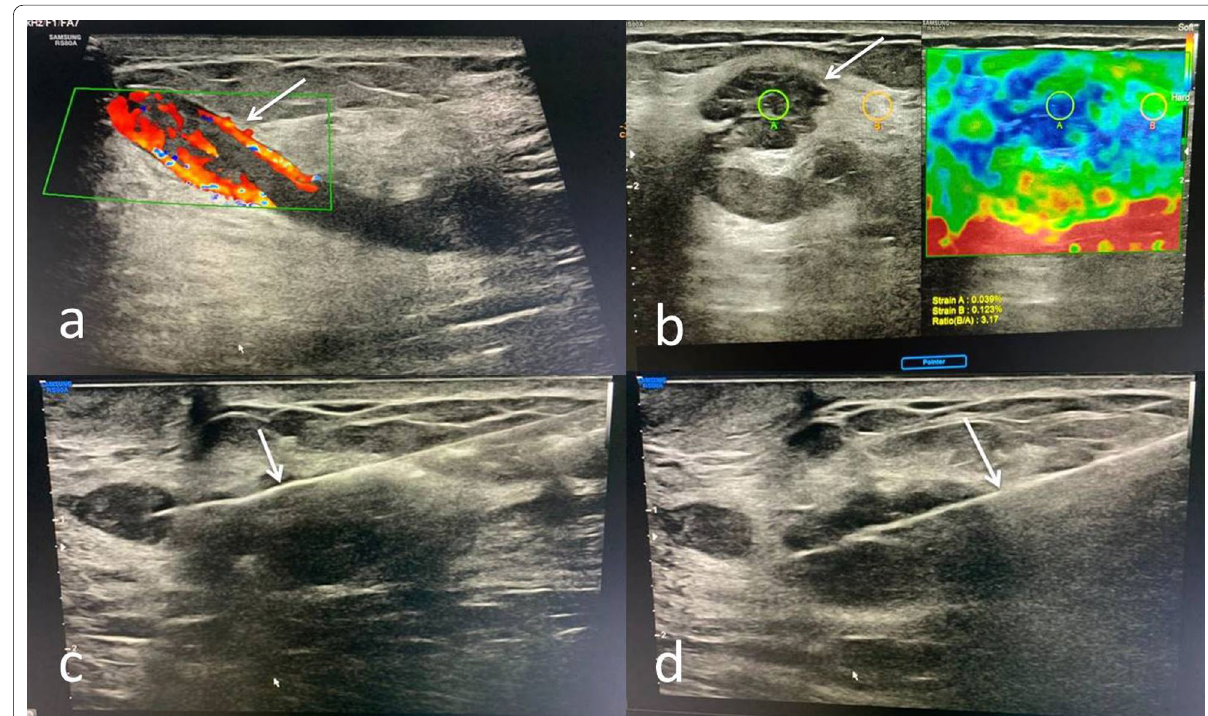
Fig. 2 Ultrasonography demonstrates dilated duct filled with a solid mass (arrow) showing increased vascularity ( a ) adjacent heterogenous hypoechoic mass with E –Strain of 3.17 ( b ), biopsy needle (arrow) seen within ductal ( c ), and associated mass ( d